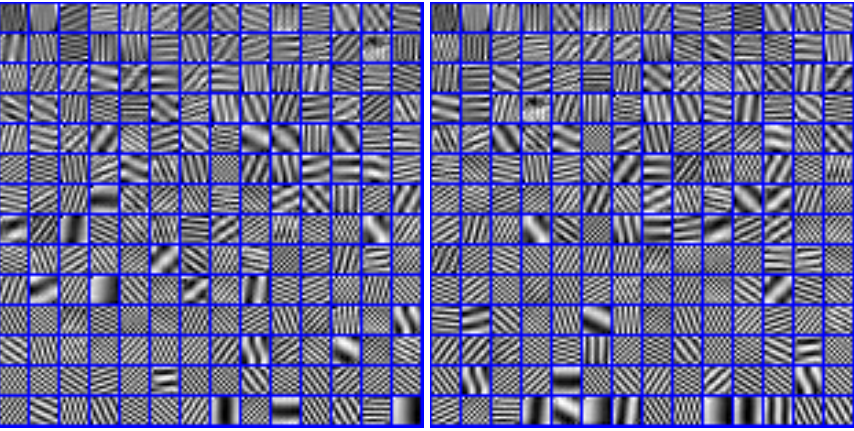
Figure 2. The exemplified dictionary pair ( Φ , Ψ ) in our stable sparse model with non-tight frame (SSM-NTF) model training by natural